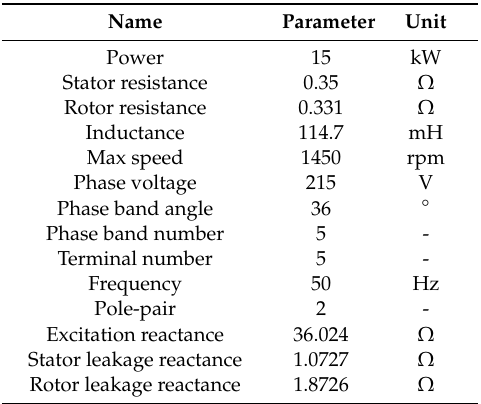
Table 2. Main parameters of the five-phase induction motor.